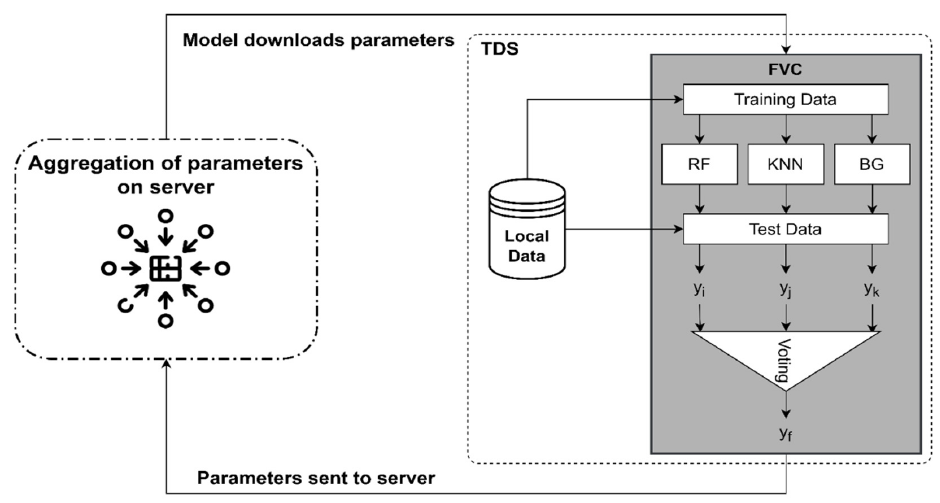
Figure 4. Functionality of the proposed FVC model.